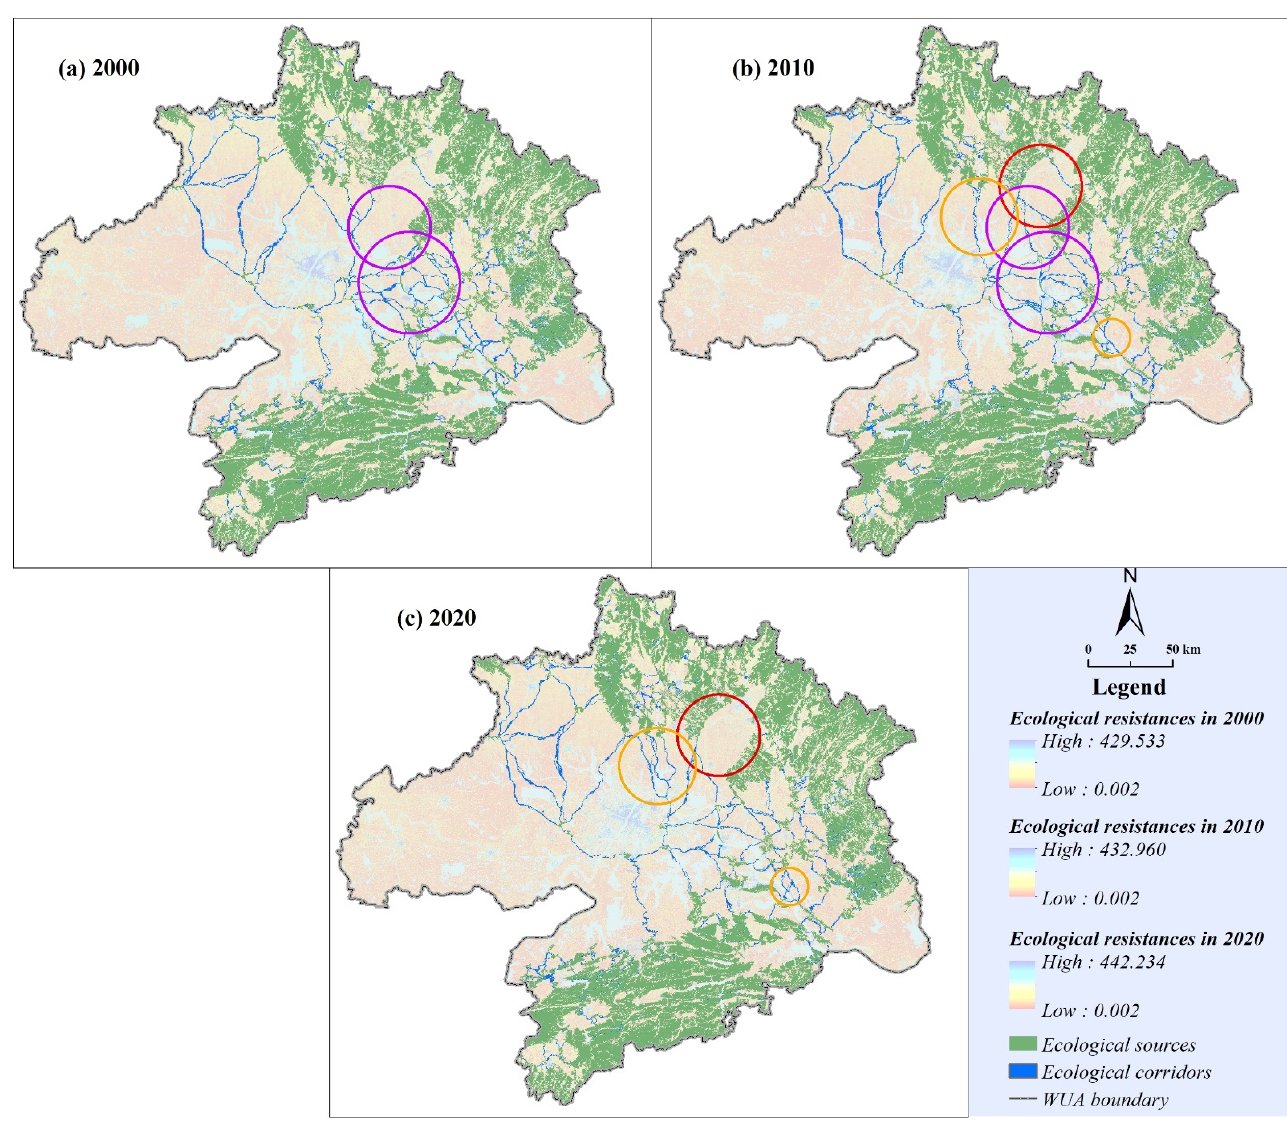
Figure 5. Spatial distribution of ENs in 2000, 2010, and 2020. Table 1. Outflow and inflow of ecological sources from 2000 to 2020.